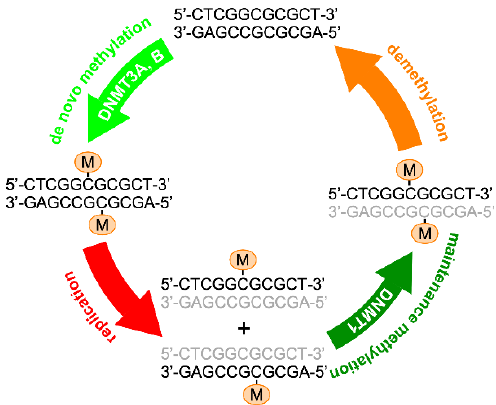
Figure 2. De novo versus maintenance DNA methylation enzymes. Unmethylated CpG sequences may undergo de novo cytosine 5-methylation, catalyzed by DNMT 3A and DNMT3B. DNA replication produces two copies of hemi-methylated double-stranded DNAs that are fully methylated by DNMT1 (maintenance methylation). Cytosine methylation may be removed through the demethylation process described in Figure 1. Grey letters and M denote newly synthesized DNA strands and the methyl group, respectively.